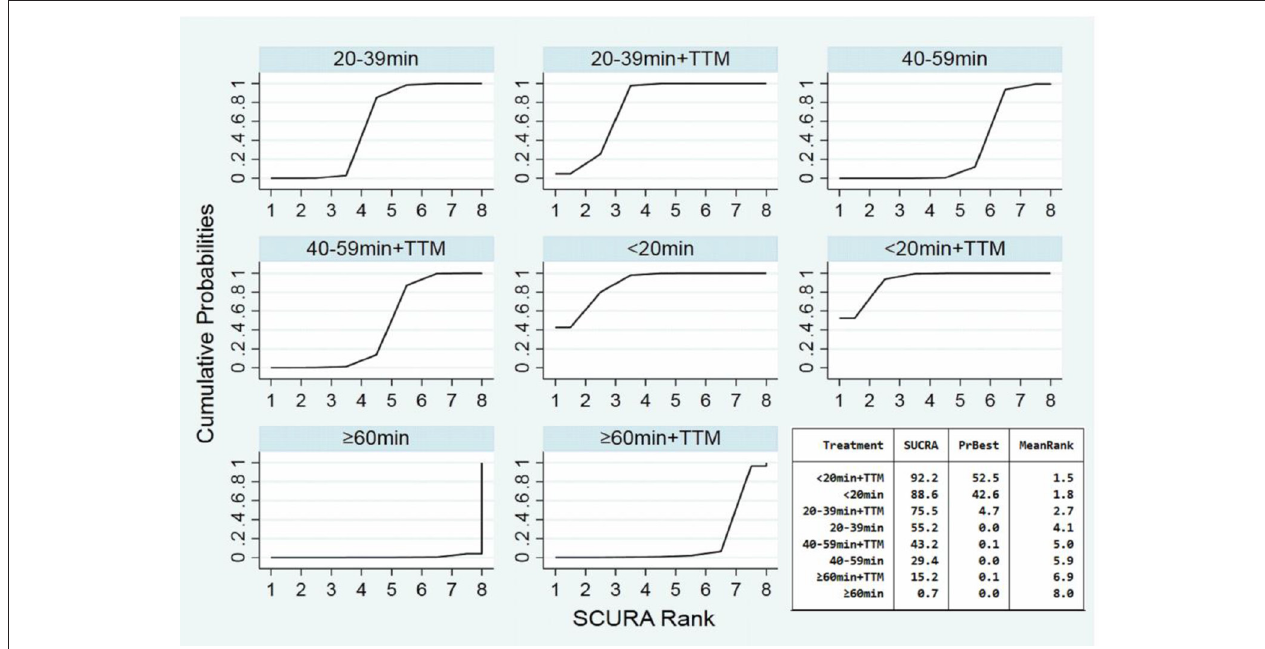
FIGURE 6 | SUCRA plot for good neurologic outcome (the area of SUCRA is shown in the lower right corner).